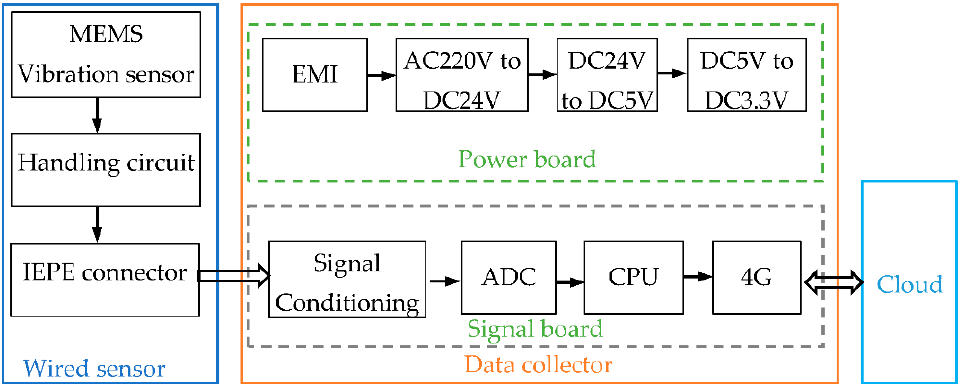
Figure 4. Block diagram of wired sensor and collector circuit principle.